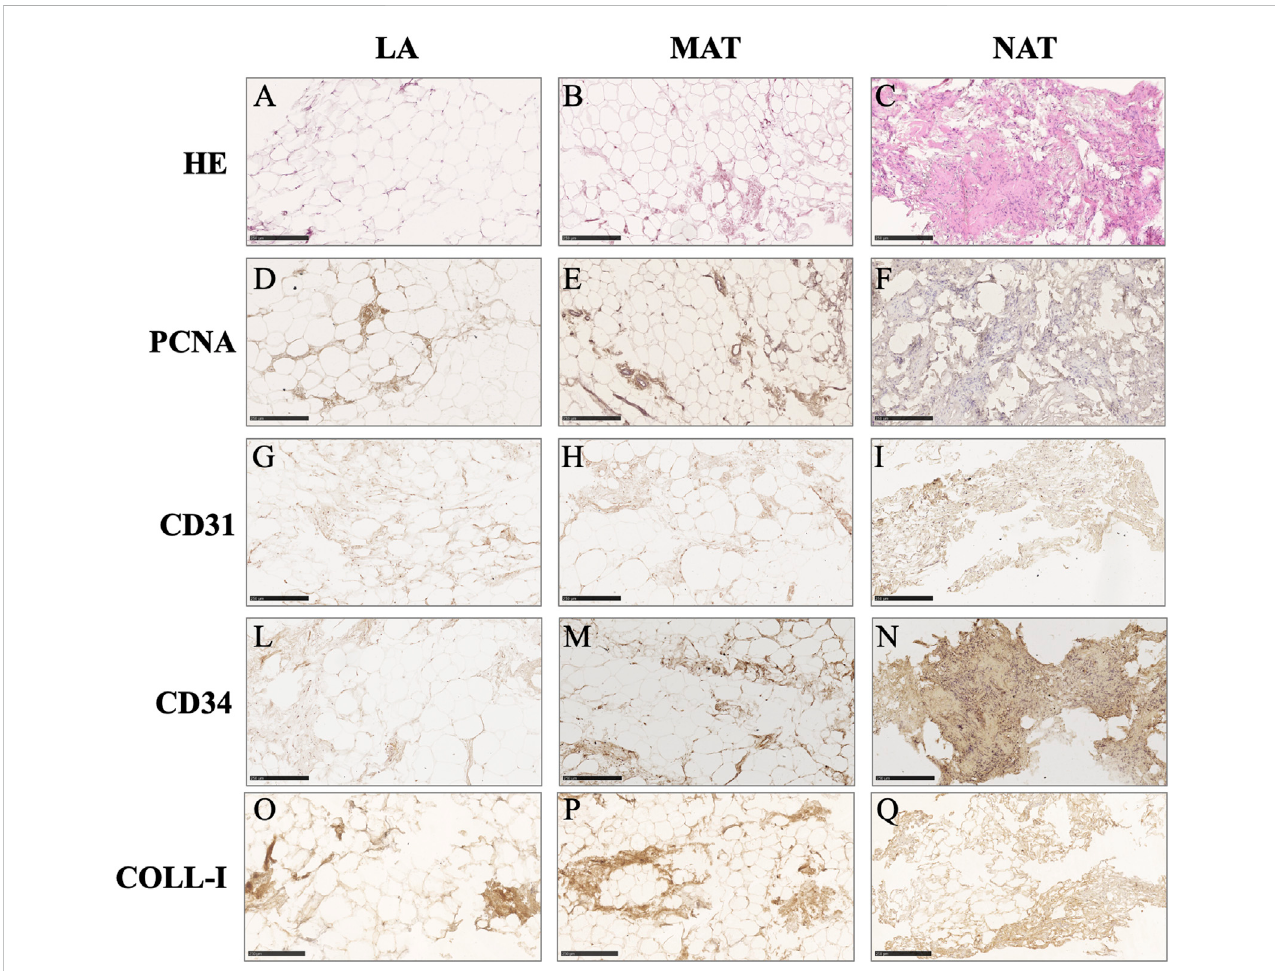
FIGURE 2 Histochemical and immunohistochemical analysis of lipoaspirate (LA), micro-fragmented (MAT) and nanofat (NAT) formalin- fi xed paraf fi n-embedded sections. Images are representative for each group. (A – C) : hematoxylin-eosin (HE); (D – F) : Proliferating cell nuclear antigen (PCNA); (G – I) : CD31 (PECAM-1); (L – N) : CD34; (O – Q) : Collagen type I (COLL-I). Scale bars = 250